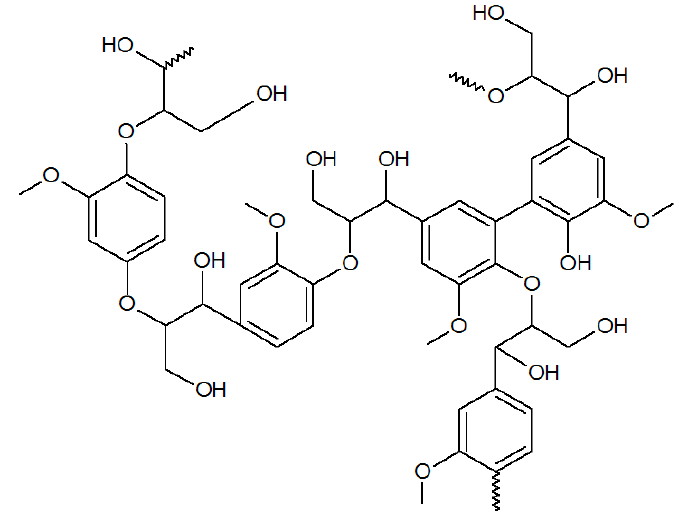
Figure 11. Chemical structure of a lignin fragment.